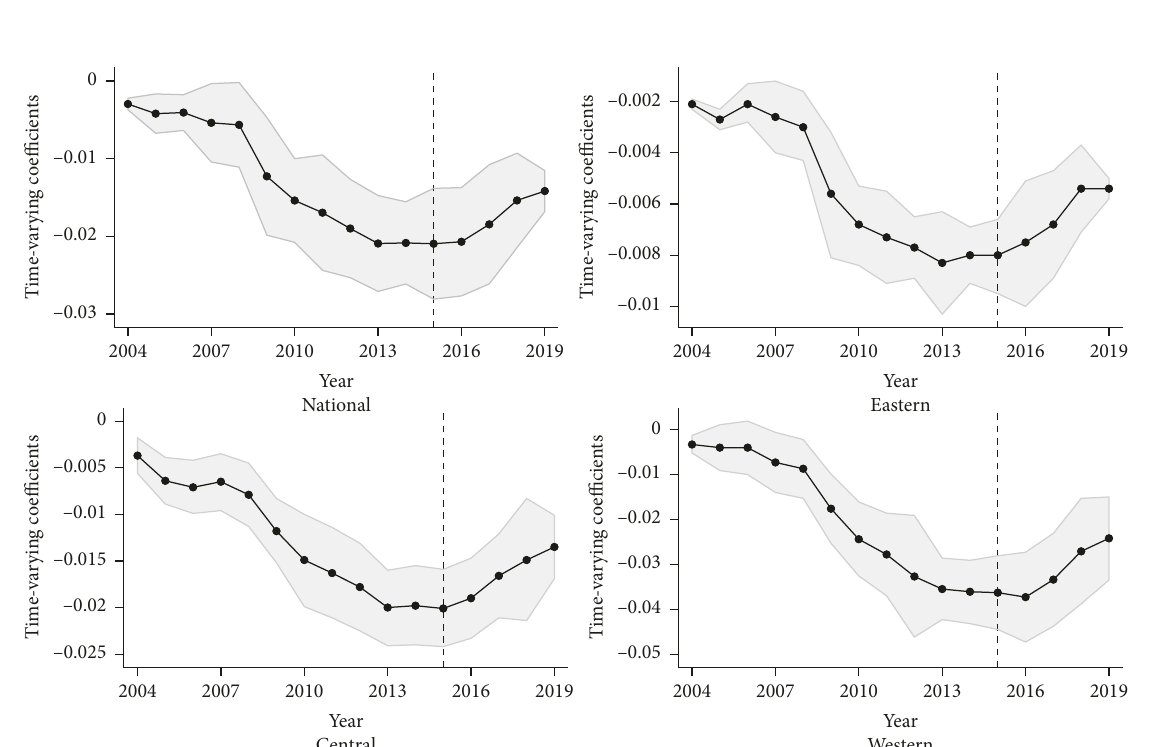
Figure 6: Robustness test (adjusting variable order).